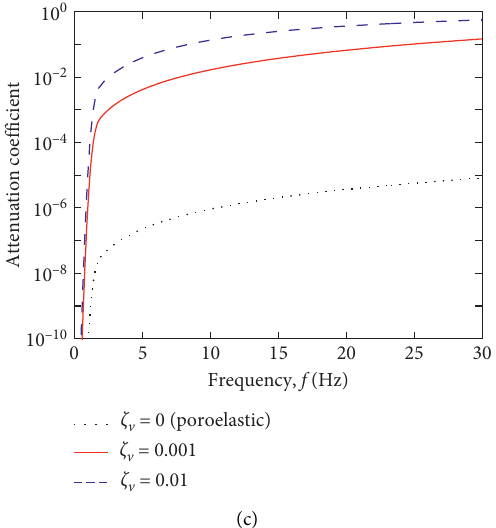
Figure 3: Variation of attenuation coefficients of P1, P2, and S waves with frequency. (a) P1 wave. (b) P2 wave. (c) S wave.